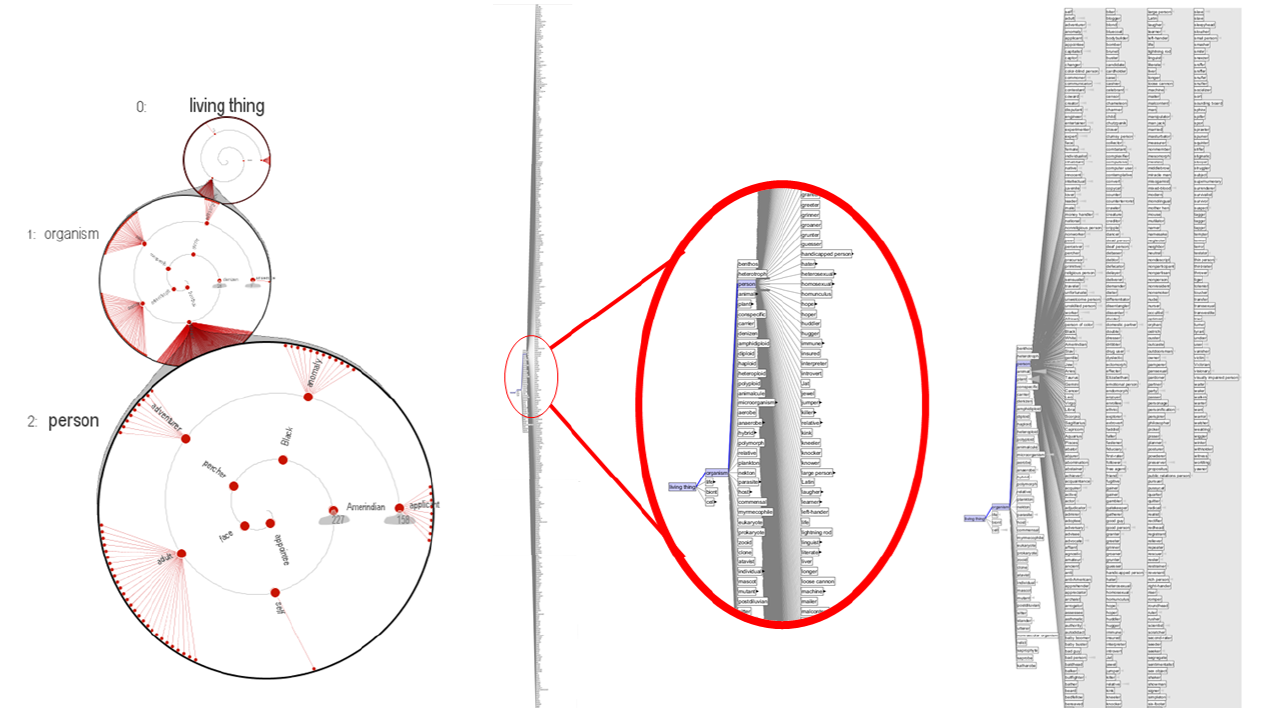
Figure 16. This Figure shows comparison of the descendant tree-cut of PaisleyTree and similar tree-cut of SpaceTree. The node person has 163 non-leaf and 232 leaf children.